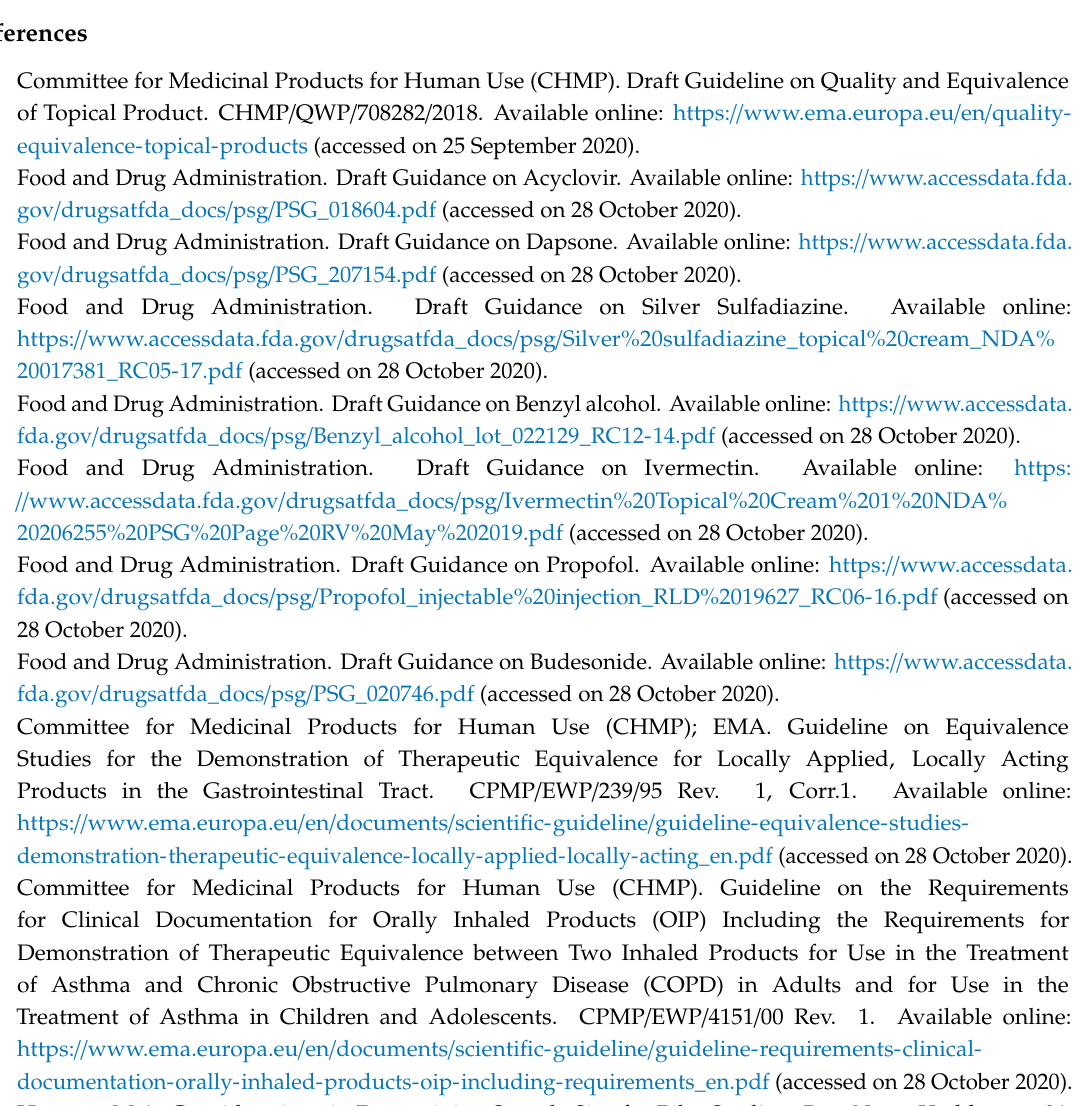
Figure S1: Distribution of the lower (top) and upper (bottom) 90% confidence intervals from each experiment ( n = 1000), stratified by the number of units (top) when the T / R ratio is 97.5%. Figure S2: Distribution of the lower (top) and upper (bottom) 90% confidence intervals from each experiment ( n = 1000), stratified by the number of batches (top) when the T / R ratio is 97.5%. Figure S3: Distribution of the lower (top) and upper (bottom) 90% confidence intervals from each experiment ( n = 1000), stratified by the number of units (top) when the T / R ratio is 95%. Figure S4: Distribution of the lower (top) and upper (bottom) 90% confidence intervals from each experiment ( n = 1000), stratified by the number of batches (top) when the T / R ratio is